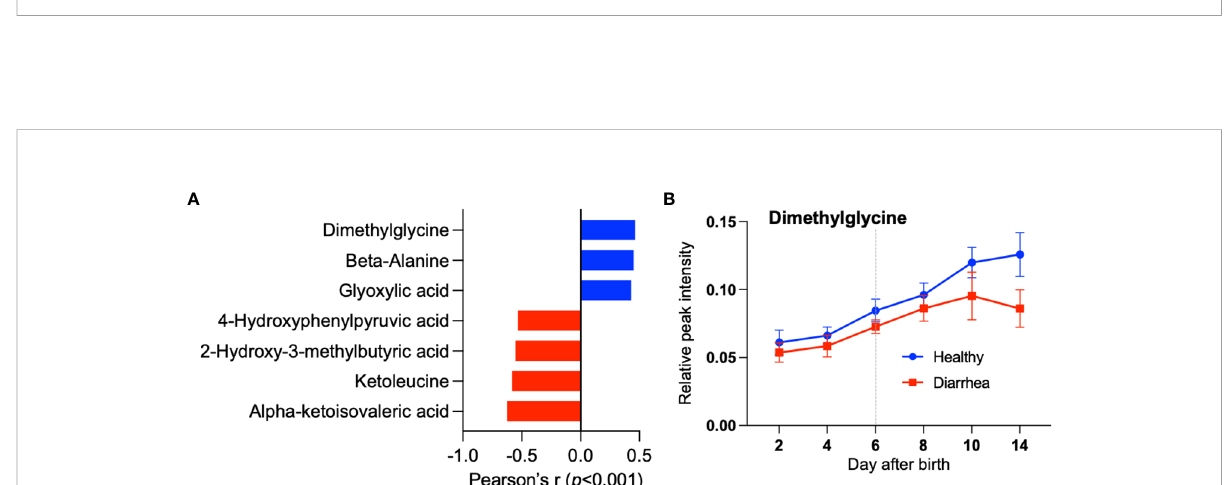
FIGURE 5 Differences in plasma metabolites between healthy and diarrheal calves. (A) Identi fi ed serum metabolites correlated with the abundance of Collinsella by Pearson ’ s correlation analysis. (B) Change of dimethylglycine in serum from healthy and diarrheal calves during milk